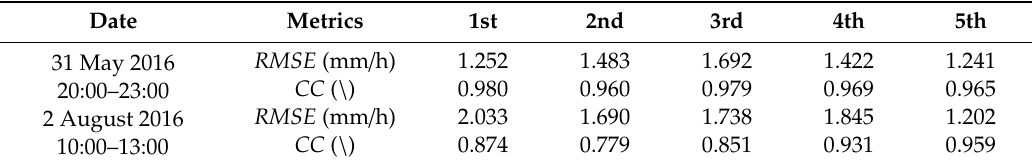
Figure 6. The comparisons between predicted results and OELs network measurements for two precipitation events (from top to bottom): 31 May 2016 and 2 August 2016. Each event is performed five continuous predictions (from left to right). Table 3. The evaluation metrics for comparisons between predictions and measurements of rainfall field for two precipitation events of May 31 and 2 August